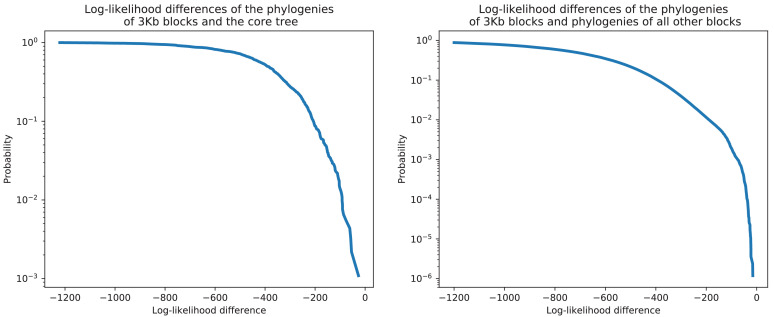
Each 3 kb alignment block rejects the core tree topology as well as the topologies of the phylogenies reconstructed from all other blocks. Left panel: For each 3 kb block in the core alignment, we used PhyML to reconstruct a phylogeny and then calculated the difference in the log-likelihood of the alignment block under the topology of the core tree and the log-likelihood of the reconstructed phylogeny. The figure shows the reverse cumulative distribution of these log-likelihood differences, with the vertical axis shown on a logarithmic scale. There are virtually no blocks for which the log-likelihood of the core tree topology is close to the log-likelihood under the block’s own phylogeny. Right panel: As in the left panel, but now we calculated, for each 3 kb block, the log-likelihood differences for the topologies of the phylogenies reconstructed from all other blocks. Each block attains a substantially higher log-likelihood when using its own topology than using the topology of any other alignment block.